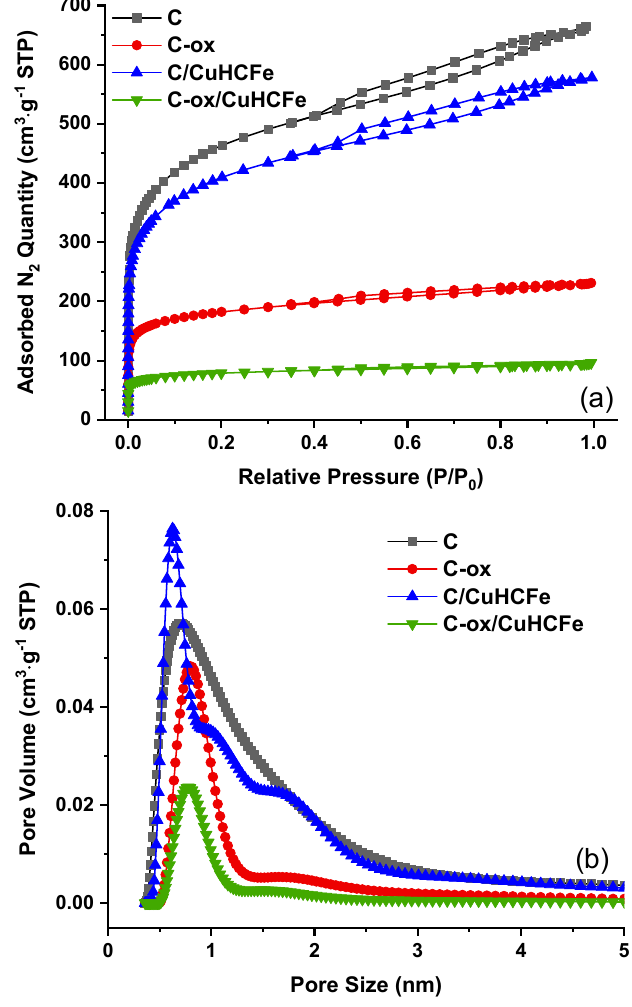
Figure 4. Nitrogen adsorption isotherms ( a ) and pore size distribution ( b ) of C, C-ox, C/CuHCFe, and C-ox/CuHCFe. The pore size distribution was calculated using the 2-D non-local density functional theory.